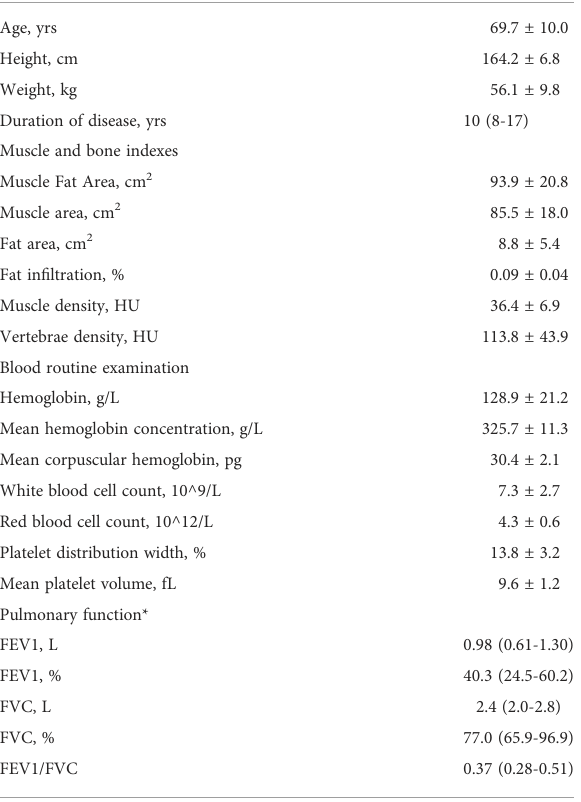
TABLE 1 Characteristics of study participants at baseline